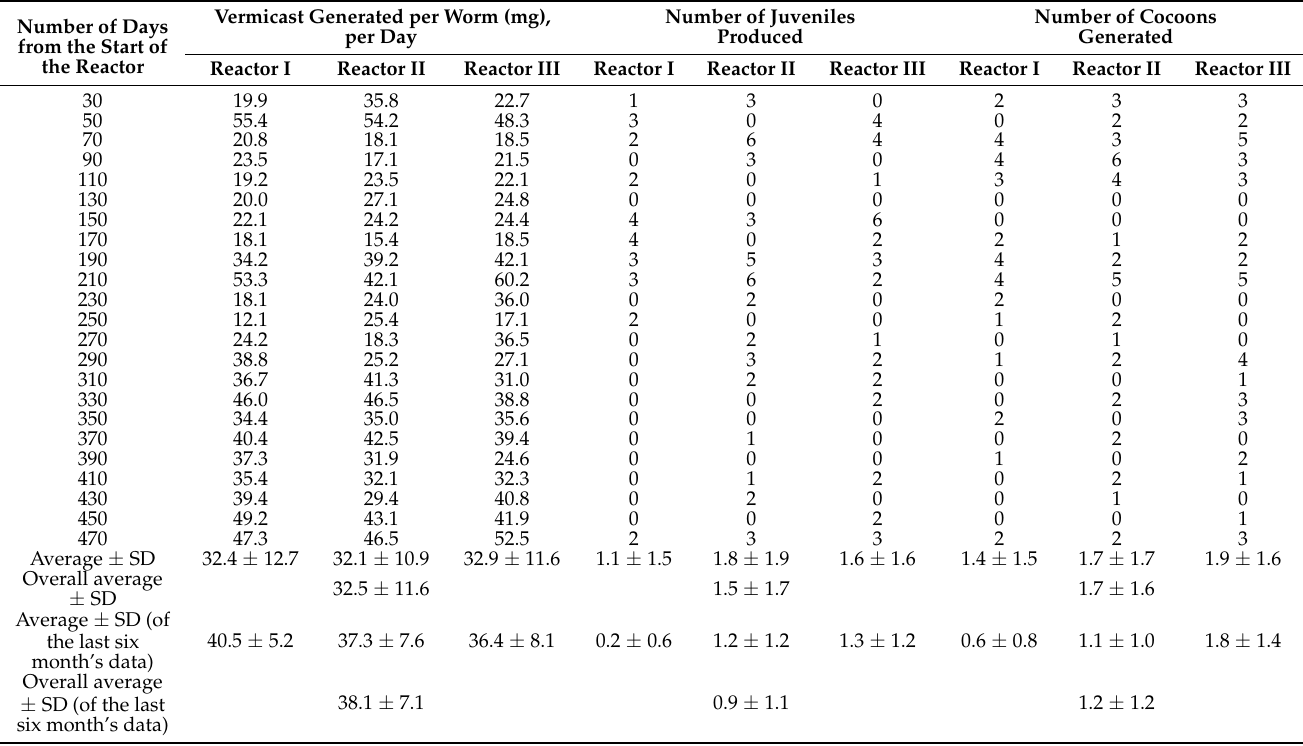
Table 6. Vermicomposting of parthenium with 20 adults of E. fetida per kg of feed in pulse-fed modules. Number of Days from the Start of the